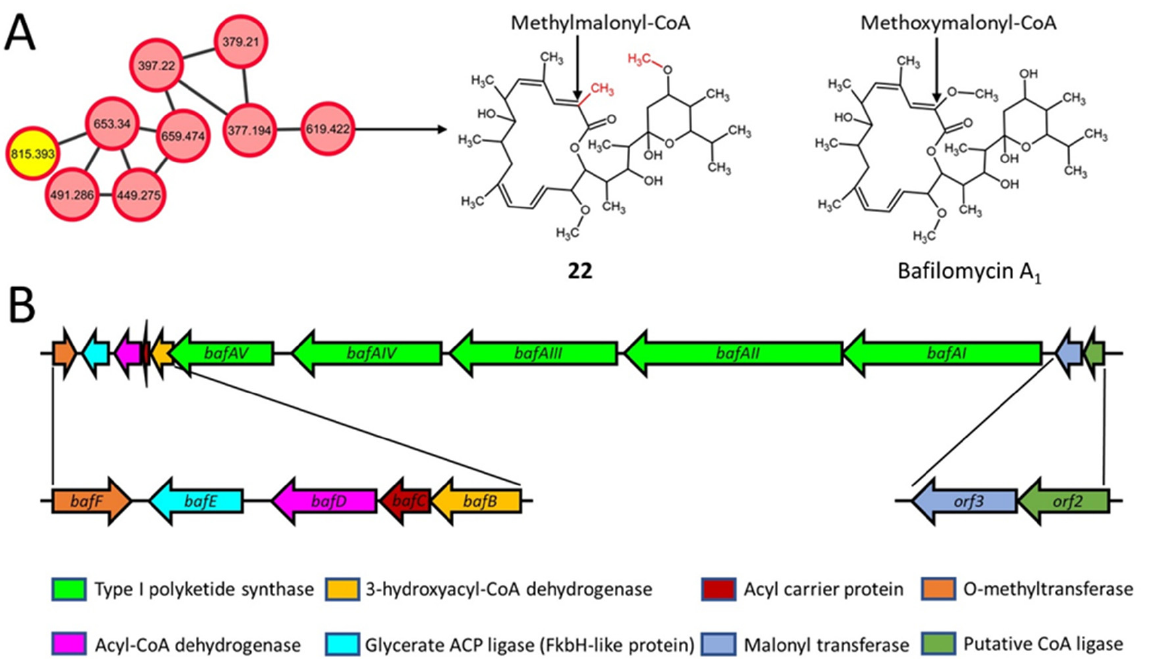
Figure 6. Molecular network (negative ionization mode) and associated biosynthetic gene cluster (BGC) for bafilomycin in S. clavuligerus . ( A ) Predicted structure of bafilomycin in a GNPS-based molecular network obtained using network annotation propagation (NAP). Each node depicts a mass spectrum (labeled with m/z of the respective precursor mass) and the edges represent the relationship between different nodes. The top-ranked NAP-consensus structural predictions (red boundary) present in all S. clavuligerus strains (pink fill) and only in the rpsL -K88E overexpression strain (yellow fill) are shown. Bafilomycin A1 is included for comparison with the predicted bafilomycin from the current study. ( B ) The bafilomycin-like BGC present in S. clavuligerus is predicted to be involved in producing the metabolite .